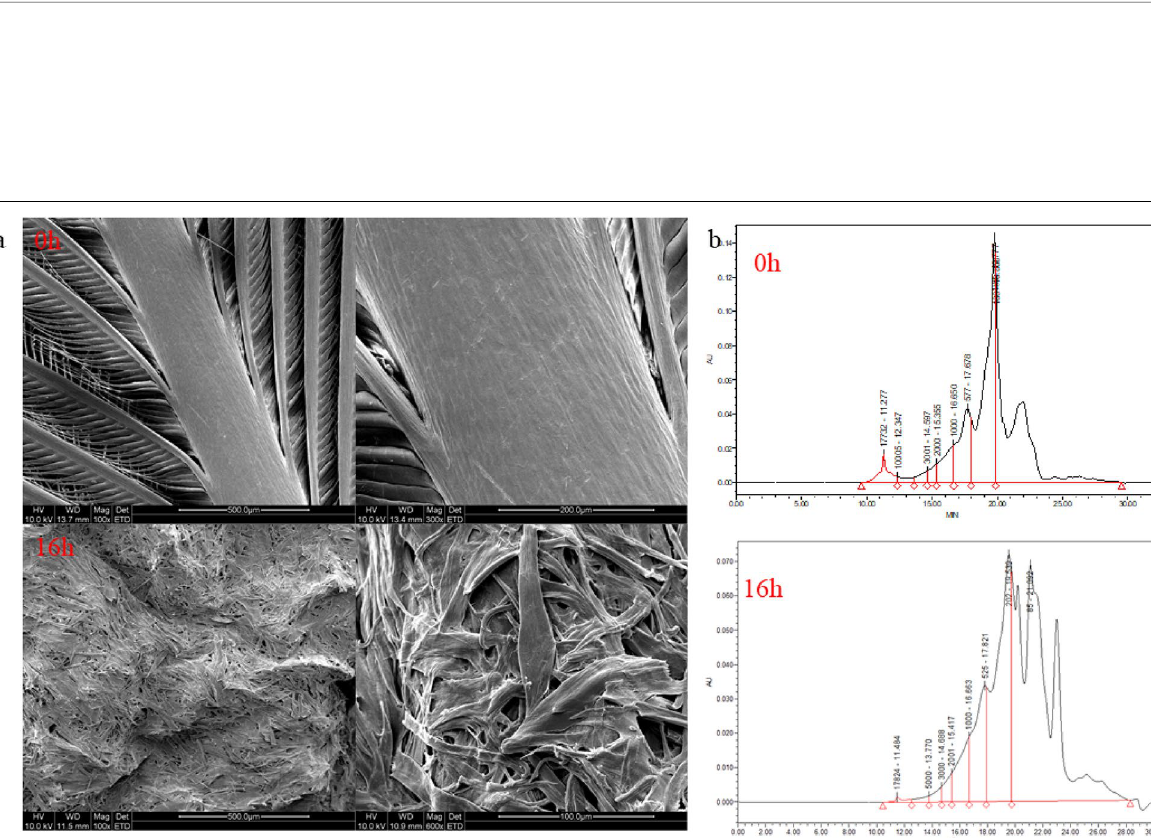
Fig. 7 Scanning electron microscopy and molecular weight distribution of the degradation products. a Scanning electron microscopy; b molecular weight distribution of